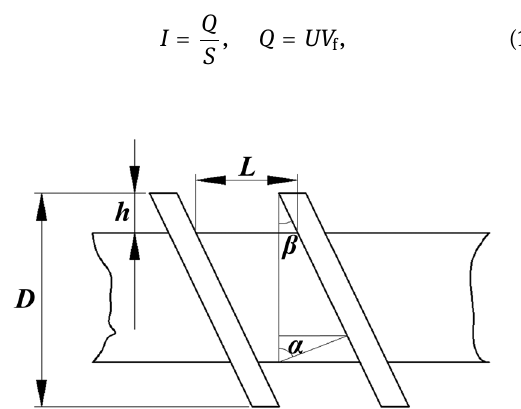
Figure 4: The structure of the screw